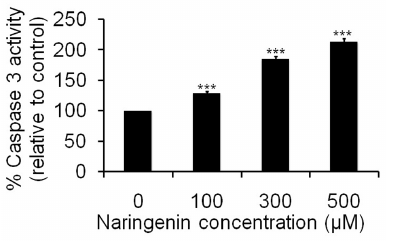
Figure 7. Activation of caspase 3 by naringenin against human skin carcinoma A431 cells. Cells were incubated with naringenion at 100 m M, 300 m M and 500 m M for 24 h. Values are expressed as means 6 SD of at least three independent experiments, **p , 0.01 and ***p , 0.001 as compared with their respective